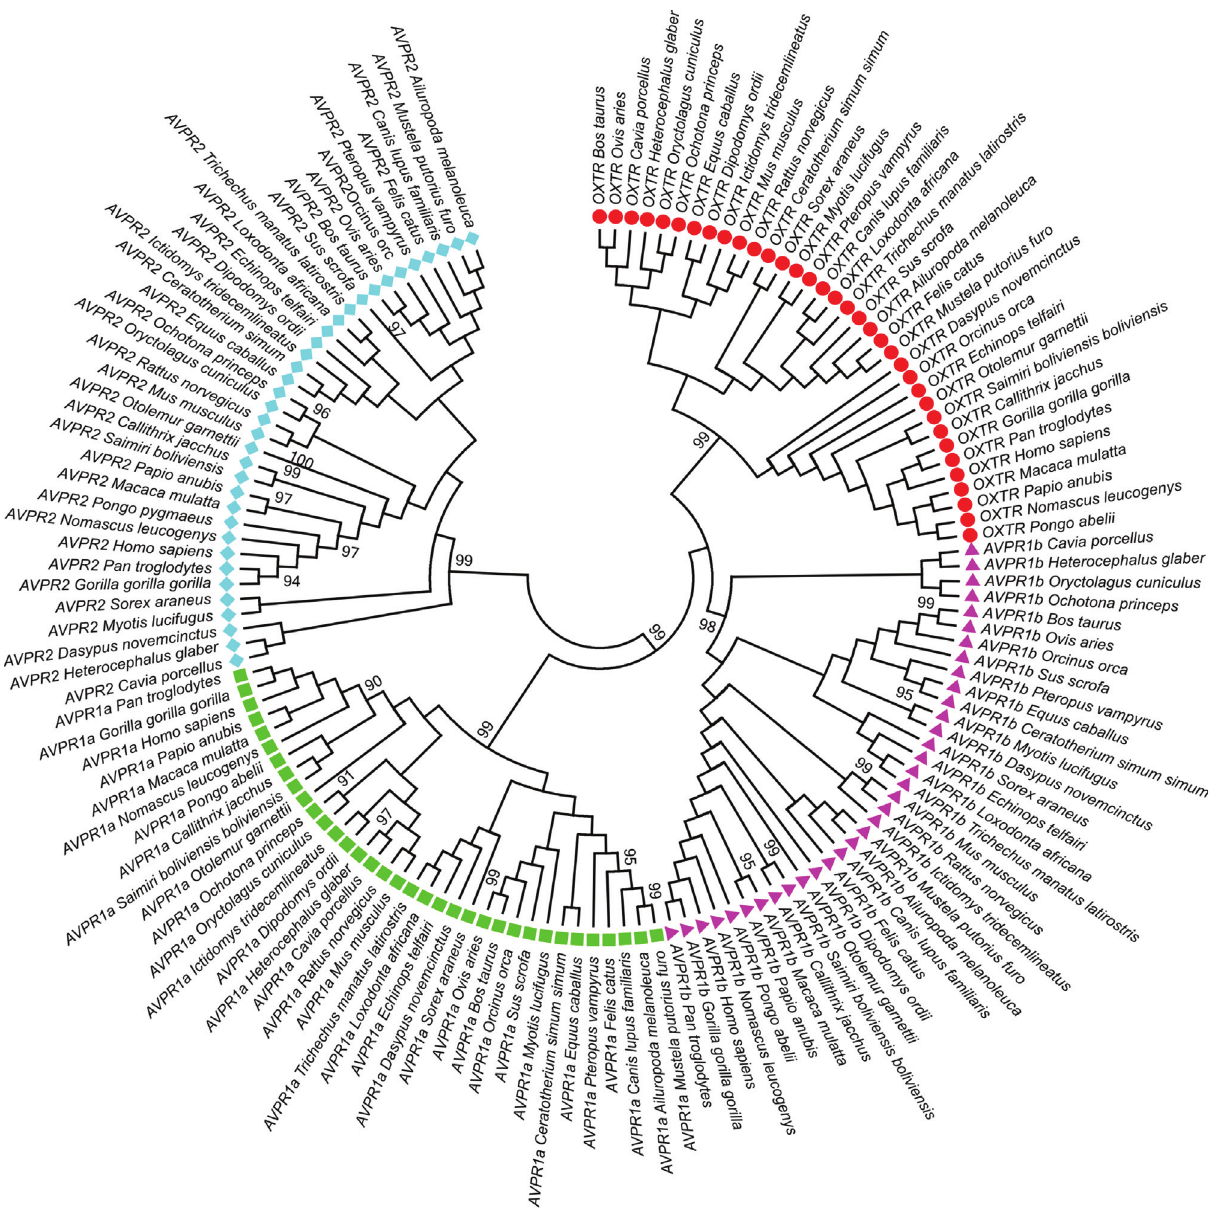
Figure 1 - Molecular Phylogenetic analysis of OXTR, AVPR1a, AVPR1b, and AVPR2 by the maximum likelihood method (as described in Materials andMethods).Theanalysisinvolved140aminoacidsequences.Allpositionswithlessthan95%sitecoveragewereeliminated.Therewereatotalof317 positions in the final